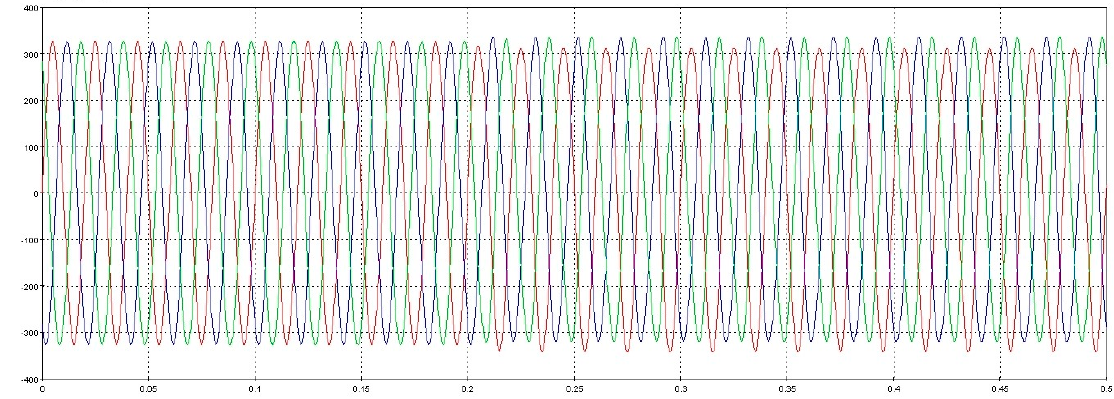
Figure 12. Output voltage waveform under droop control.